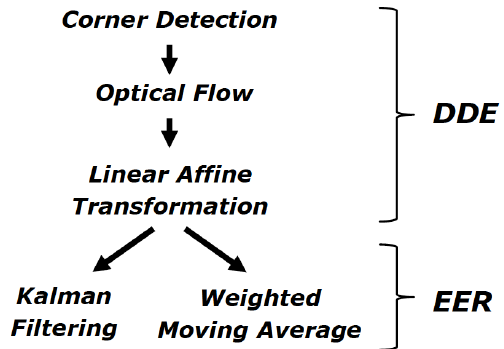
Figure 1. Tracking approach of ARIANNA system